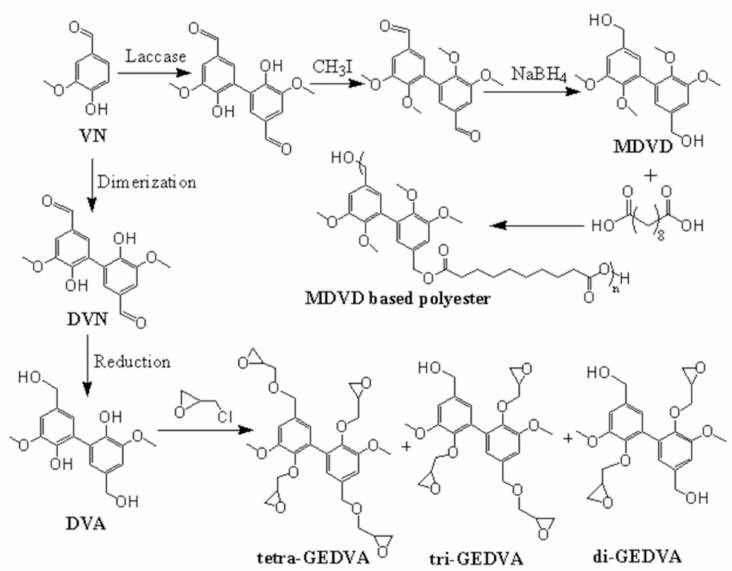
Figure 10. Representative reaction scheme for the development of MDVD-based polyester and GEDVA